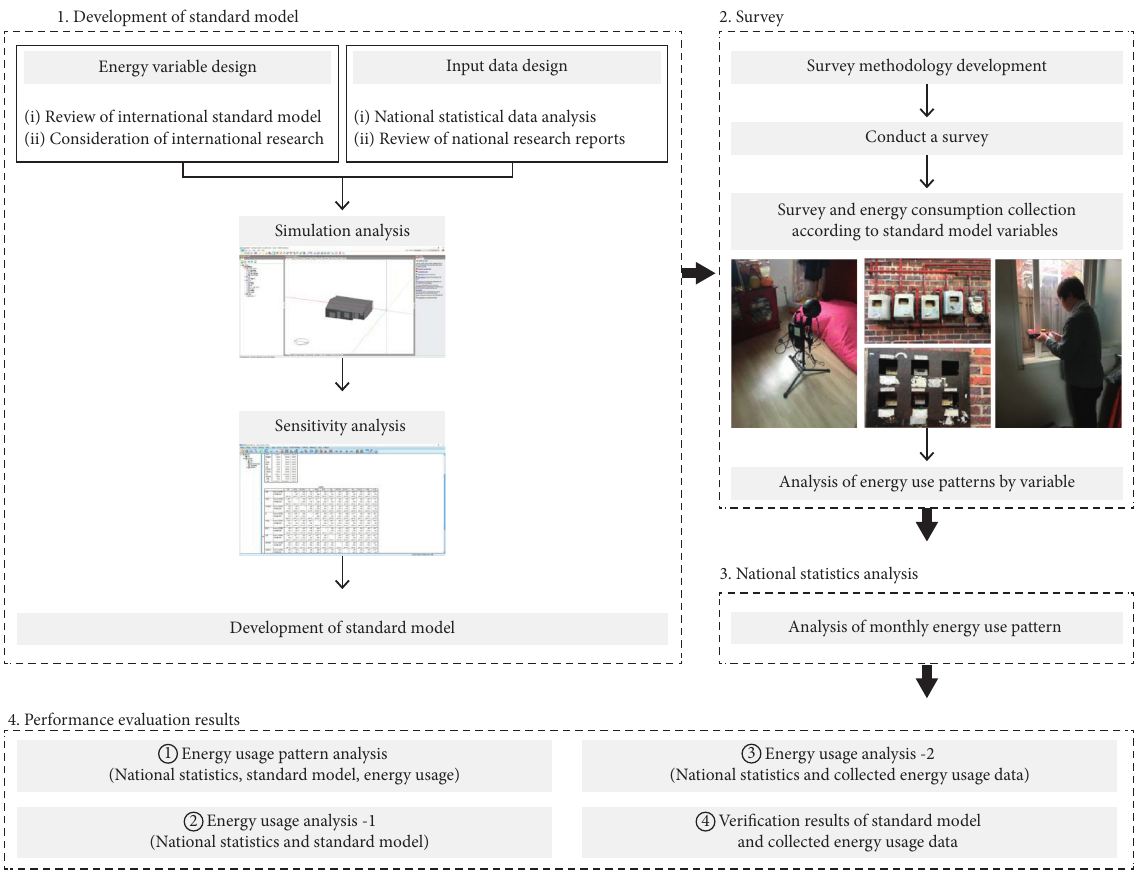
Figure 1: Schematic representation of the methodology used in this